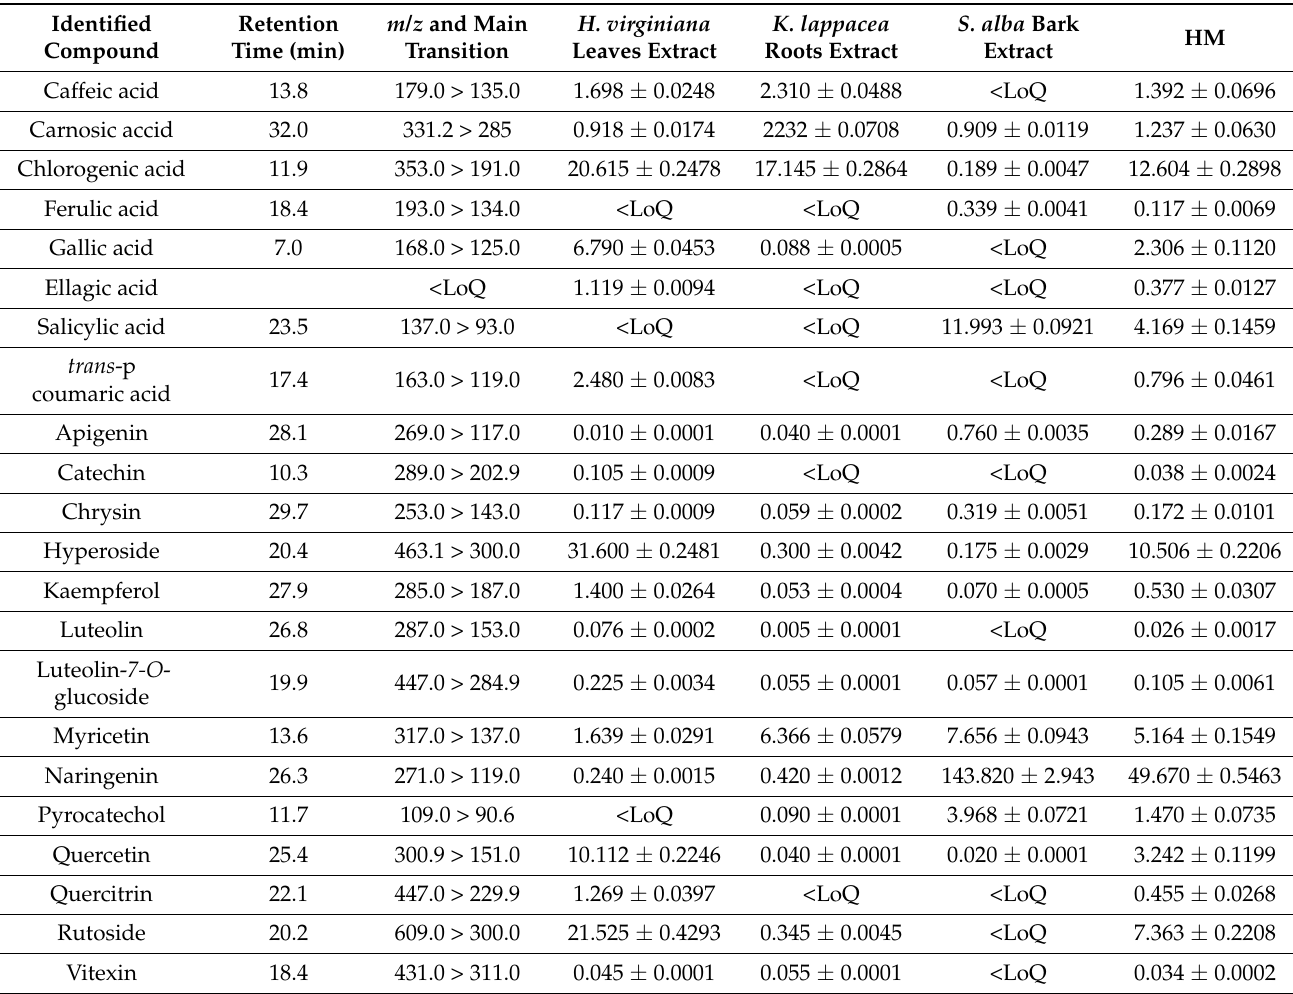
Table 1. LC/MS identification and quantification (mg/mL) of polyphenols in the composition of the individual extracts and HM.